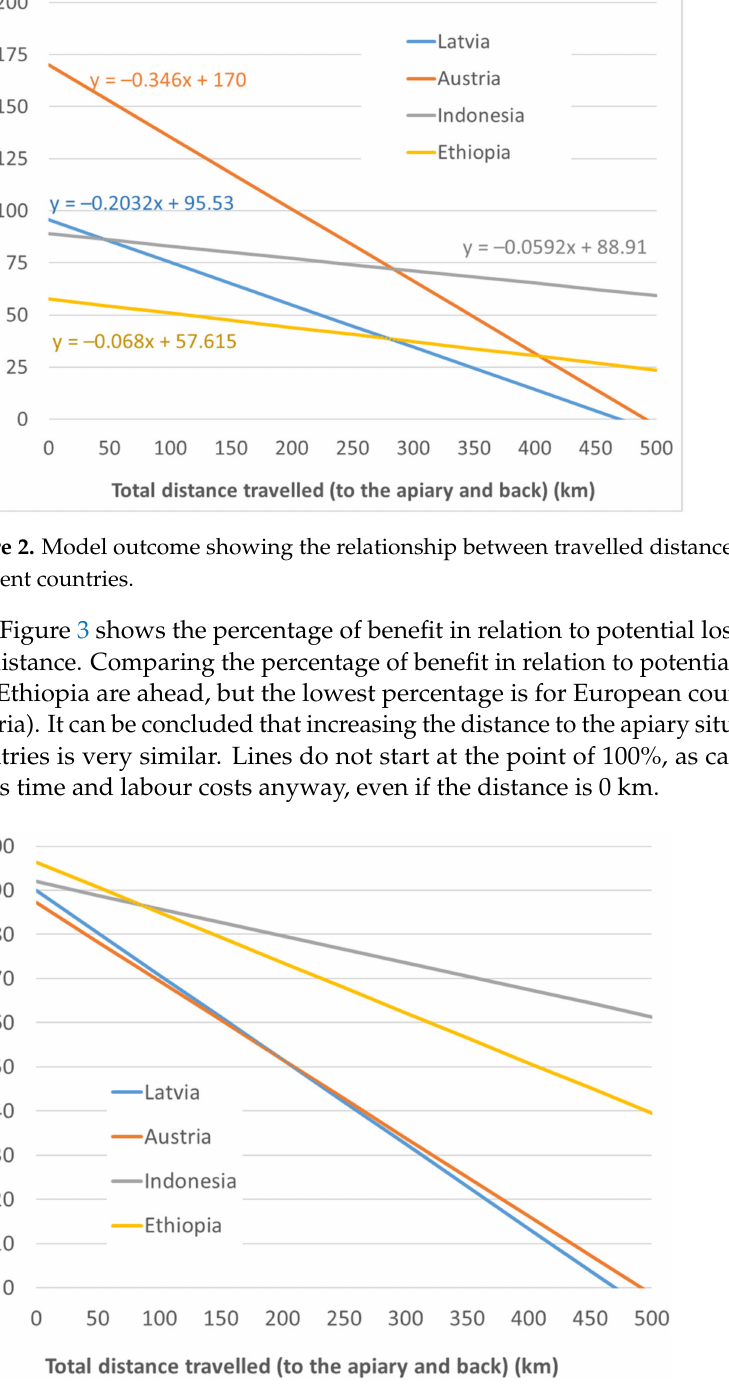
Figure 3. Percentage of benefit in relation to potential losses in dependence on